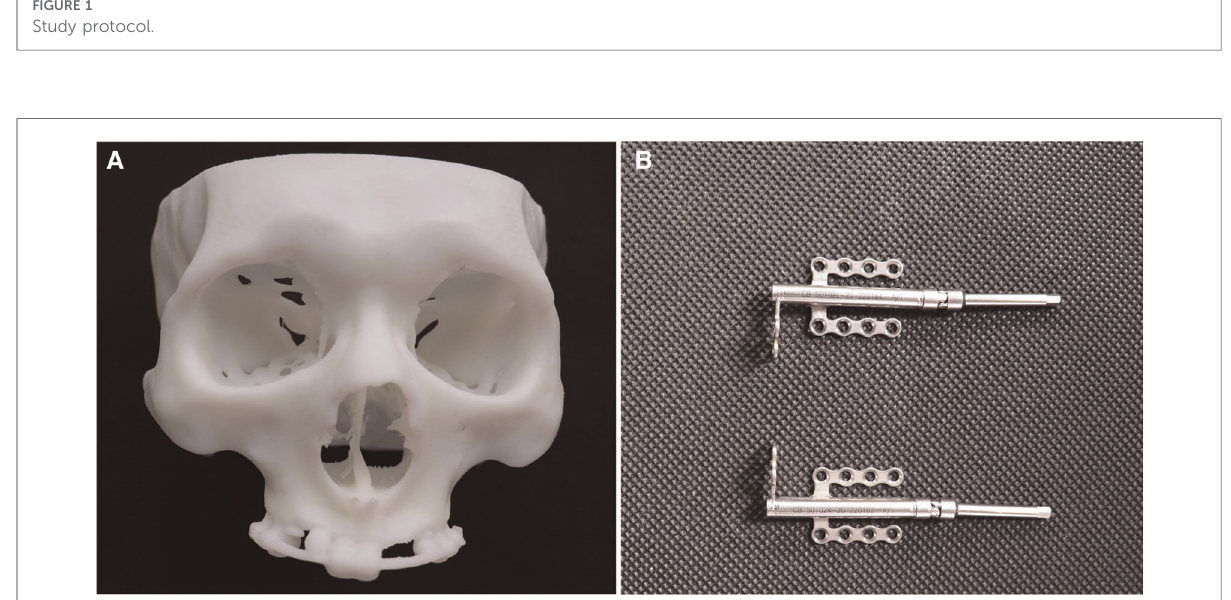
FIGURE 2 Phantom and distractors note: the 3D-printed skull phantom ( A ) and distractors ( B ) were applied in this